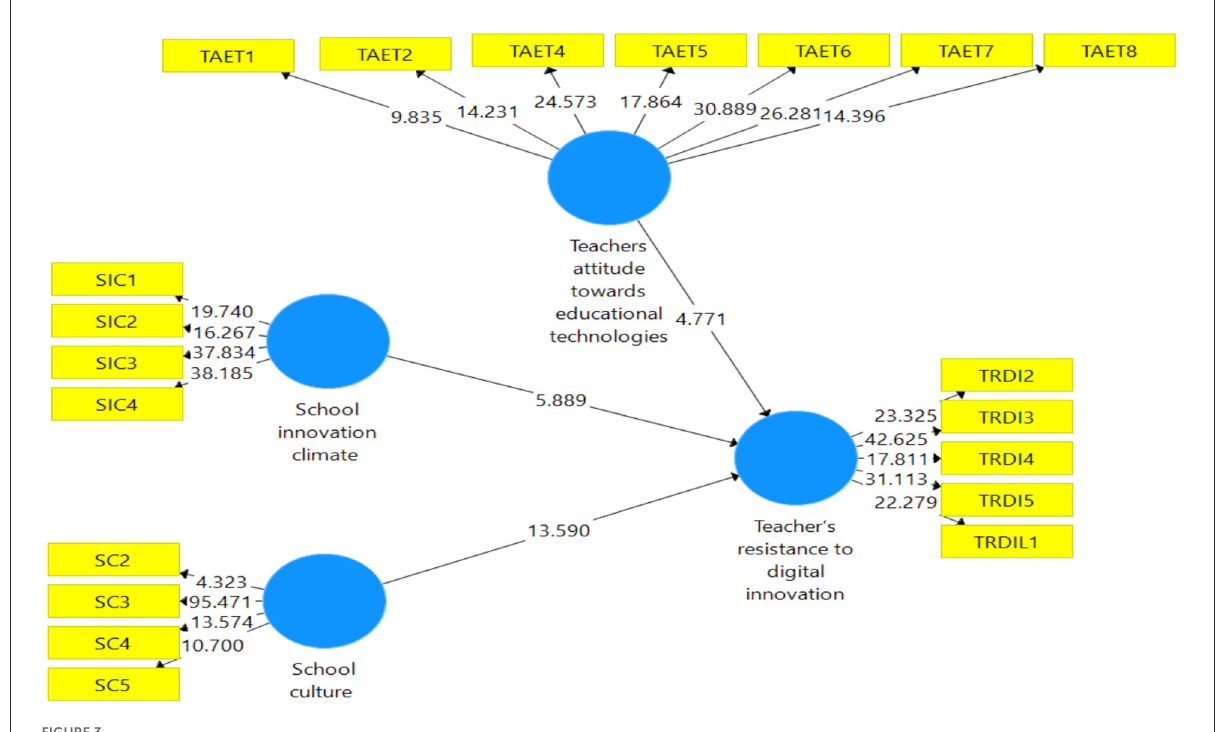
FIGURE3 Assessment of PLS